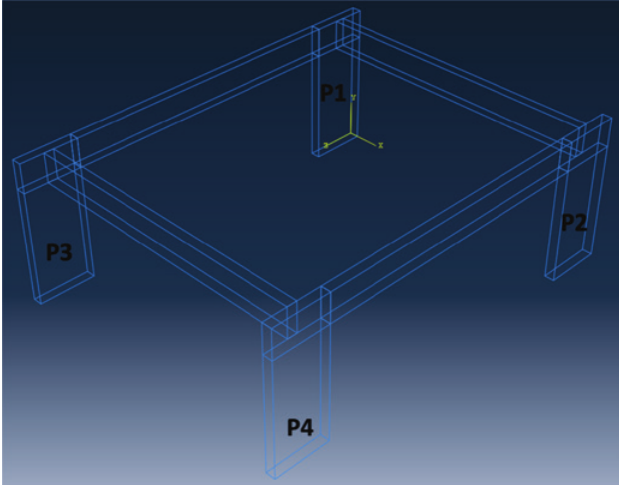
Figura 7 Sistema de coordenadas adotado e identificação dos pilares-parede